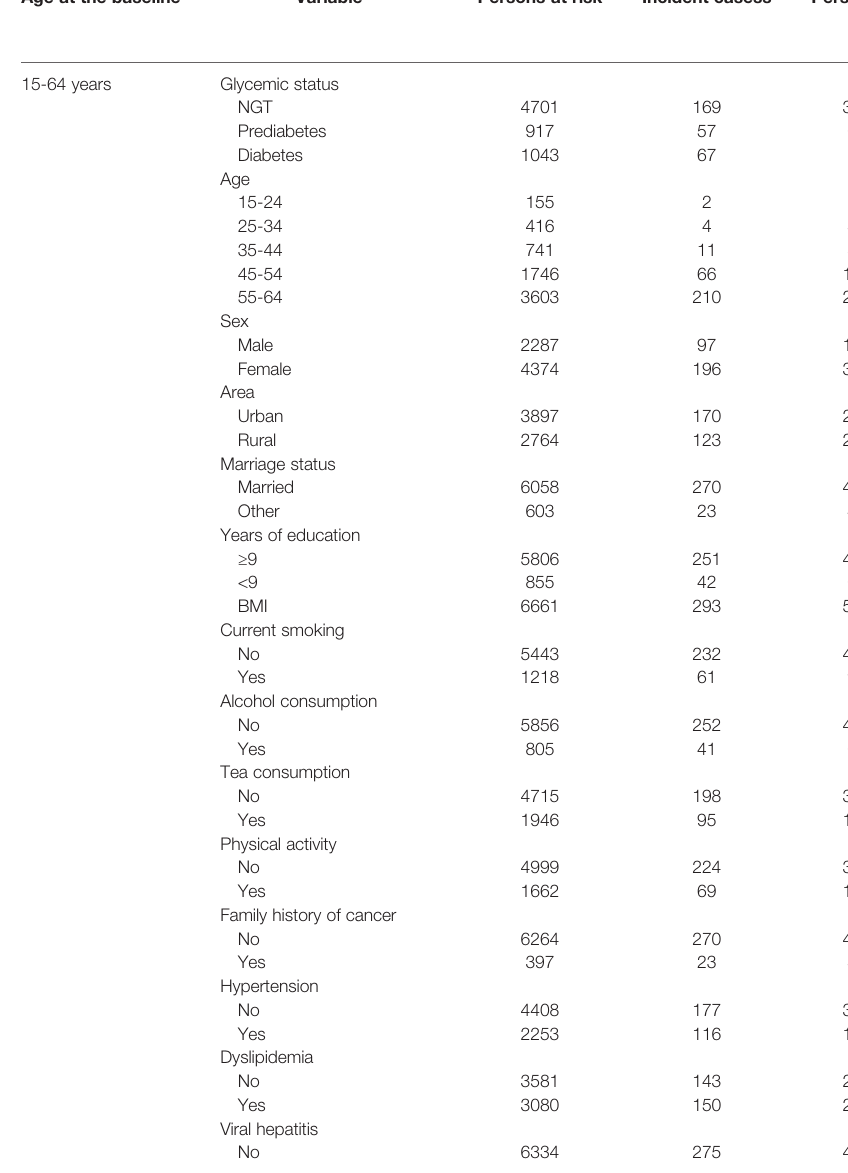
TABLE 2 | Cox regression analysis of factors signi fi cantly affected cancer incidence in cohort participants, strati fi ed by age group. Age at the